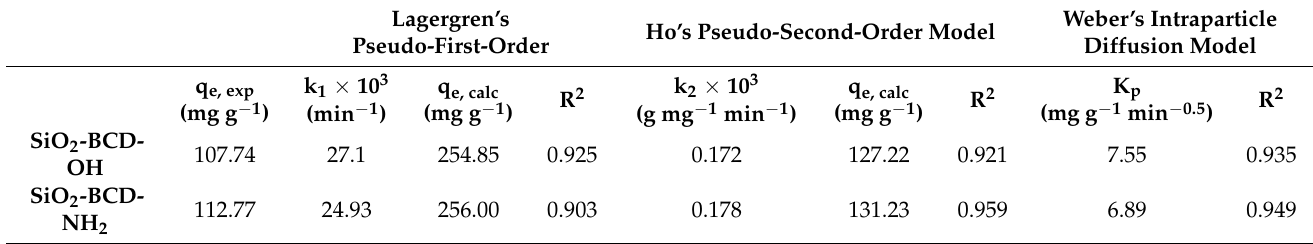
Table 1. Kinetic parameters for the adsorption of bisphenol A by SiO 2 -BCD-OH and SiO 2 -BCD-NH 2